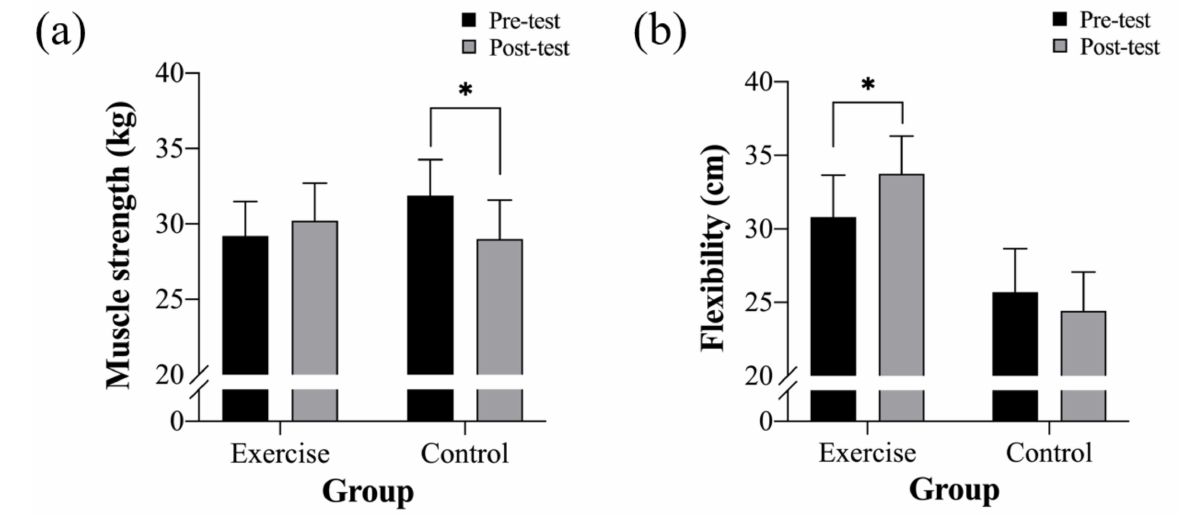
Figure 2. Changes in physical fitness over time between multi-component exercise (exercise) and control groups: ( a ) muscle strength and ( b ) flexibility. * Significant difference between the pre-test and the post-test. Table 3. Changes in physical fitness over